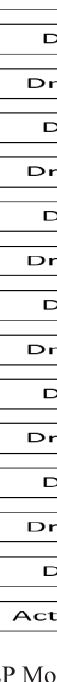
Fig. 3 6-Layer MLP Model For Random Forest, we used 50 estimators and the criterion used was entropy. Rest of the parameters were set to default.